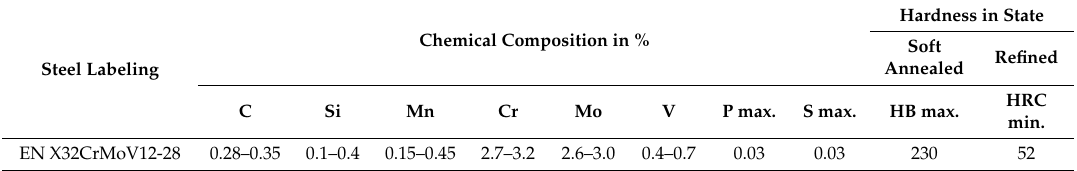
Table 4. Basic chemical composition of tool steel EN X32CrMoV12 ‐ 28 [18].